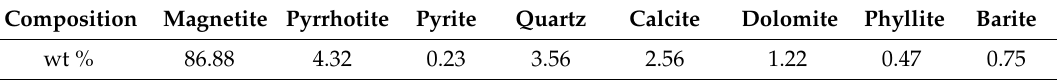
Table 2. Analysis of iron chemical phase in the magnetic concentrate (mass fraction, %).